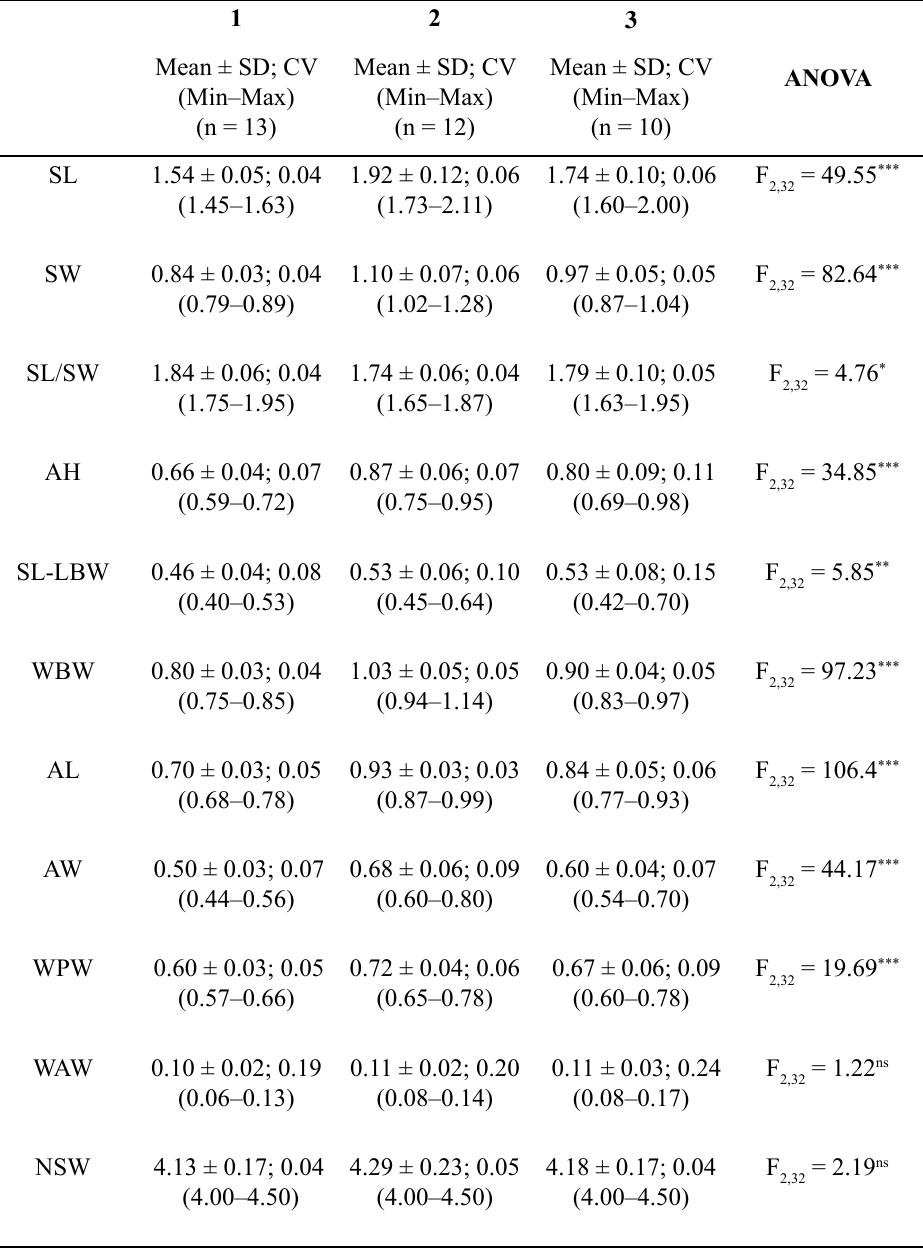
Table 2. Shell measurements (in mm) for the species. 1. Belgrandiellopsis chorfensis gen. et sp. nov. from Chorfa Spring. 2. B. secunda gen. et sp. nov. from Ettoute Spring. 3. Biserta putealis gen. et sp. nov. from Soudene Well. *** P < 0.001; ** P < 0.01; * P < 0.05; ns, not